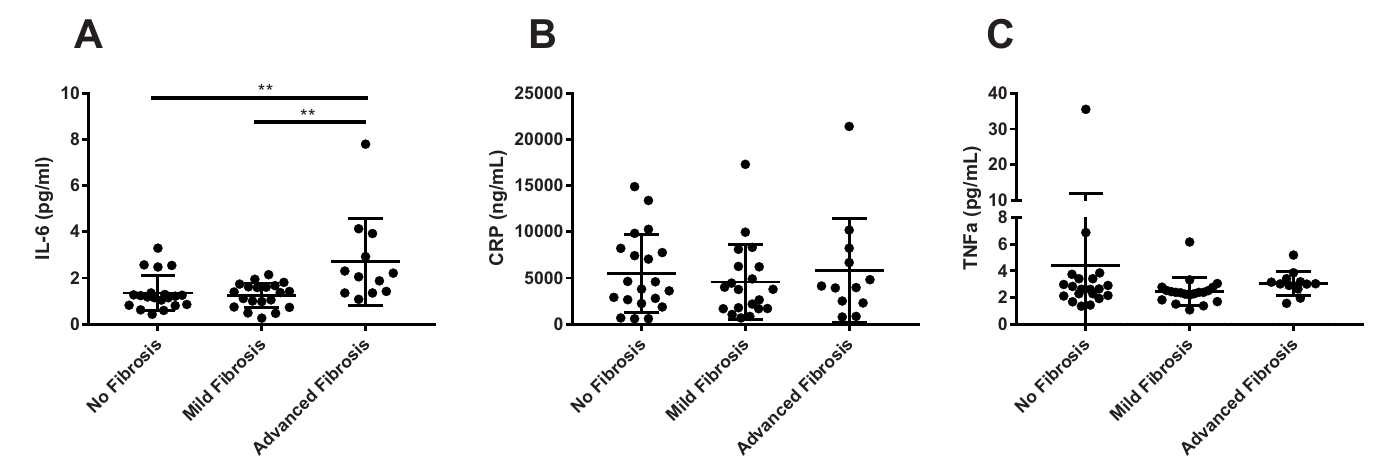
Fig 2. Inflammatory cytokines analyzed by NASH fibrosis severity. (A) IL-6, (B) CRP, and (C) TNF- α . �� p < 0.01 vs Advanced Fibrosis group.